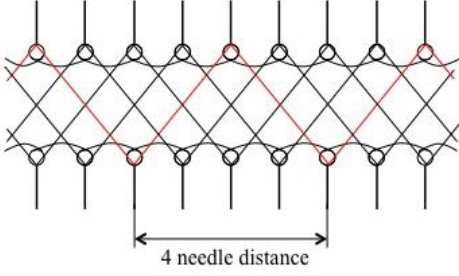
Figure 1. Spacer fabric structure with four-needle connecting distance.